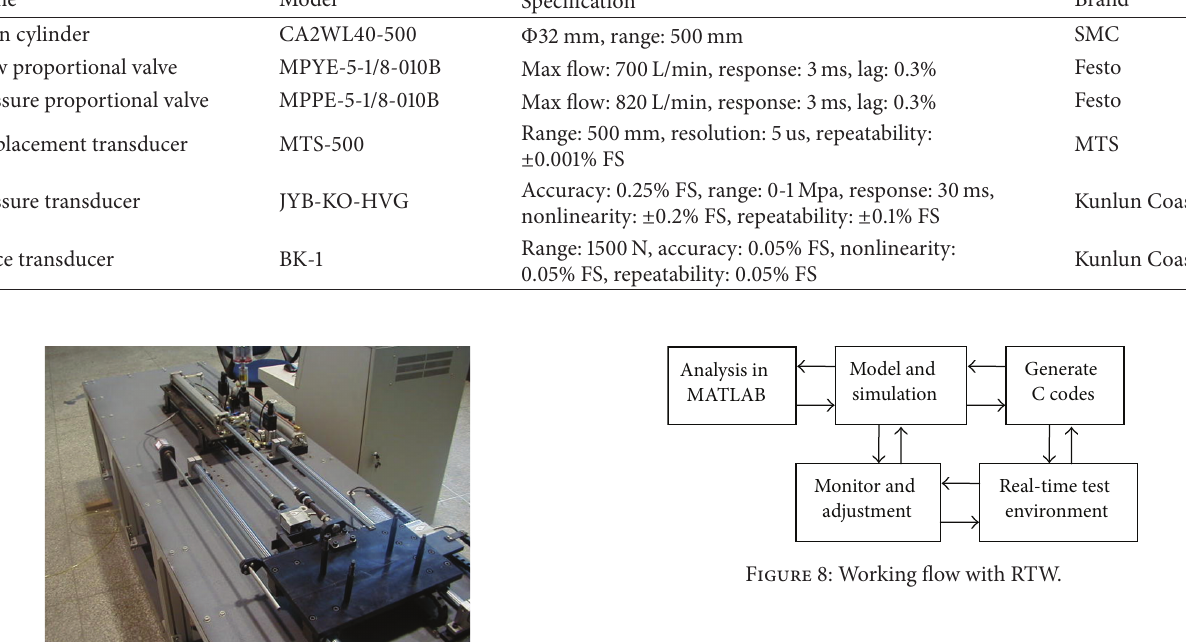
Table 5: Control errors of cylinder position